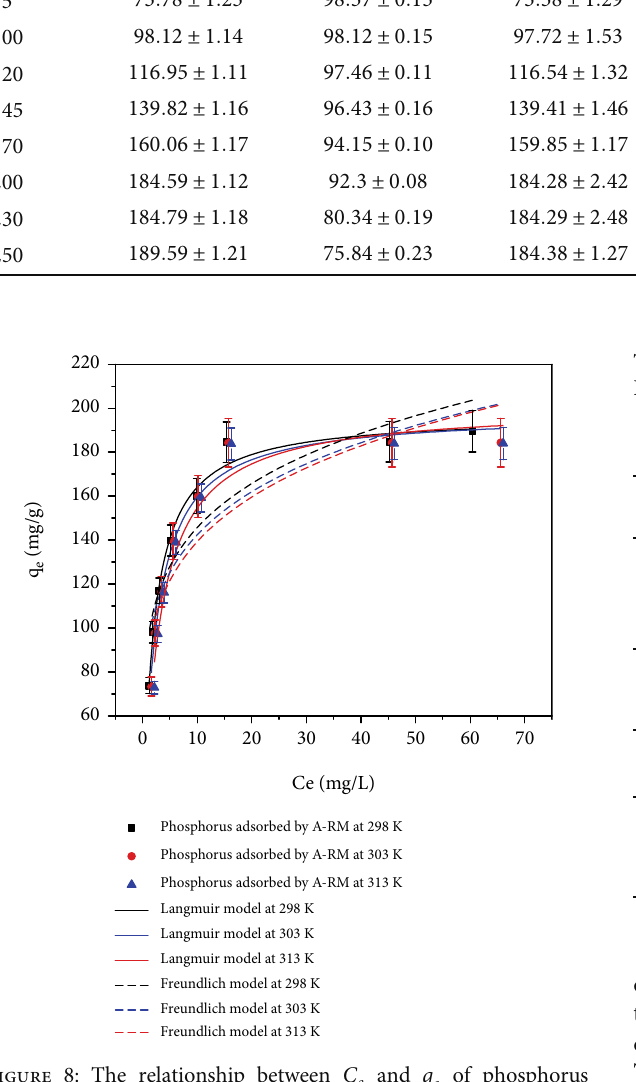
Figure 8: The relationship between C adsorption at pH = 5 .